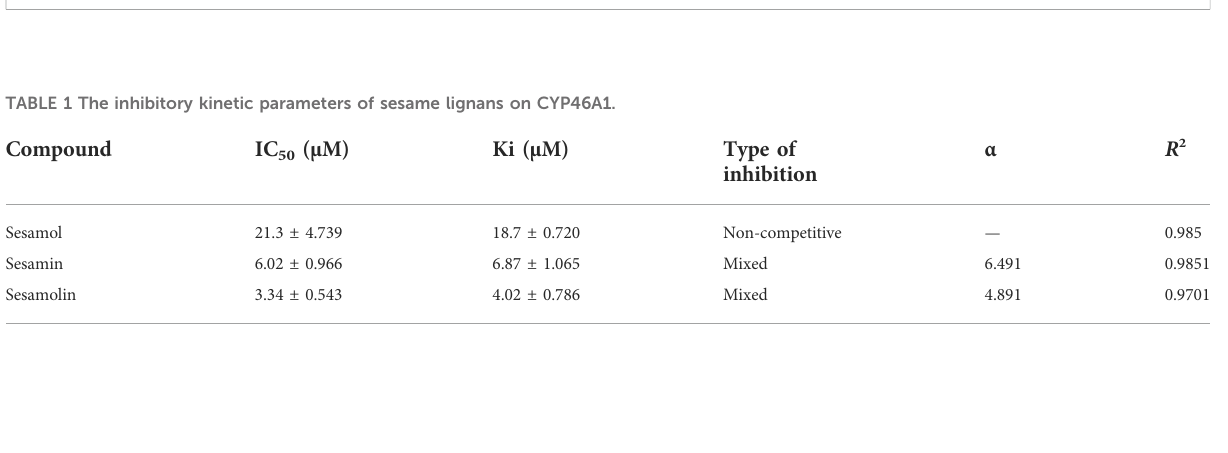
FIGURE 4 Lineweaver-Burk plots (A,C, and (E)) and Dixon plots (B,D, and (F)) for the inhibition effects of sesamol, sesamin, and sesamolin against CYP46A1 activity using testosterone as the substrate (B,D, and (F)) . Data points were from three independent experiments.